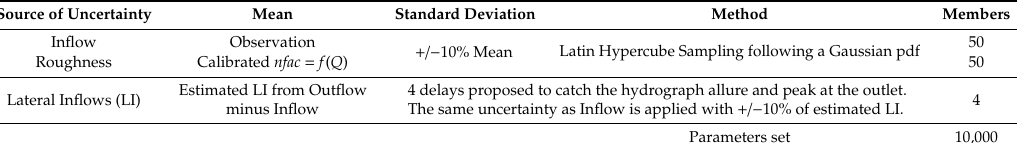
Table 3. Characterization of the accounted sources of